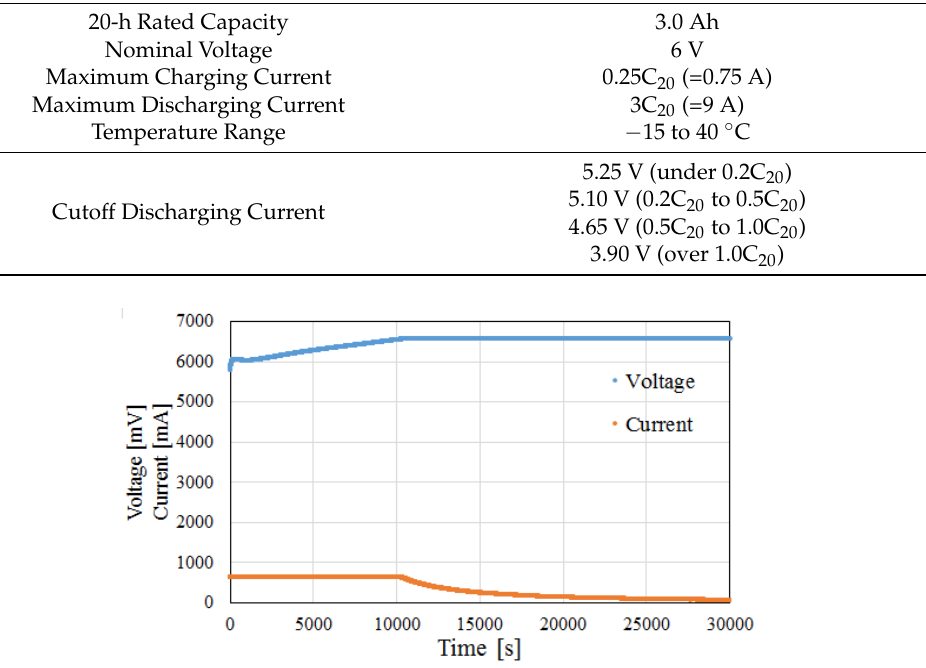
Table 3. Primary Specifications of the valve-regulated lead-acid battery.